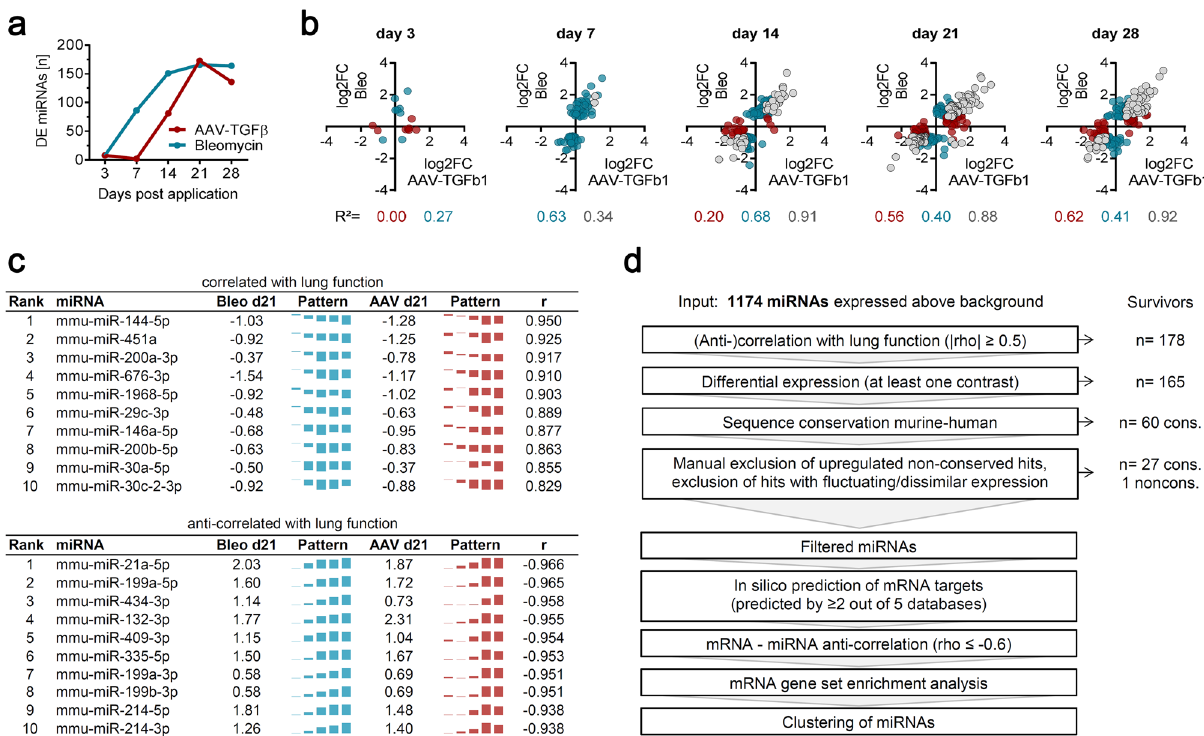
Figure 5. Longitudinal assessment of miRNAs and lung function association in AAV-TGFβ1 and Bleomycin induced fibrosis. Small RNAs were applied to next-generation sequencing analysis. ( a ) Number of differentially expressed miRNAs over time. ( b ) Correlation plots for miRNAs showing differential expression either exclusively in one model or commonly in both models, as defined by expression cutoffs (log 2 FC = 0.6). The coefficient of determination (R 2 ) is show for each set of genes under the graphs. ( c ) The top 10 miRNAs most strongly anti-/correlated with the decline in lung function (Fig. 1i) are shown together with their log 2 fold change in expression on day 21 and the expression pattern over all five time points. The mean Pearson correlation coefficient r over both models is also depicted. ( d ) Staged selection strategy to identify novel miRNA candidates for further characterization. rho = Spearman’s rank correlation coefficient. For further details, see results and